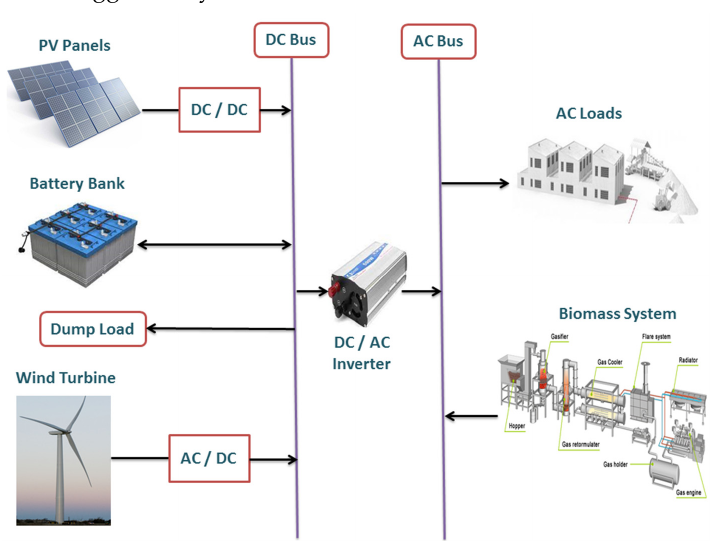
Figure 1. The architecture of the proposed stand-alone hybrid system.